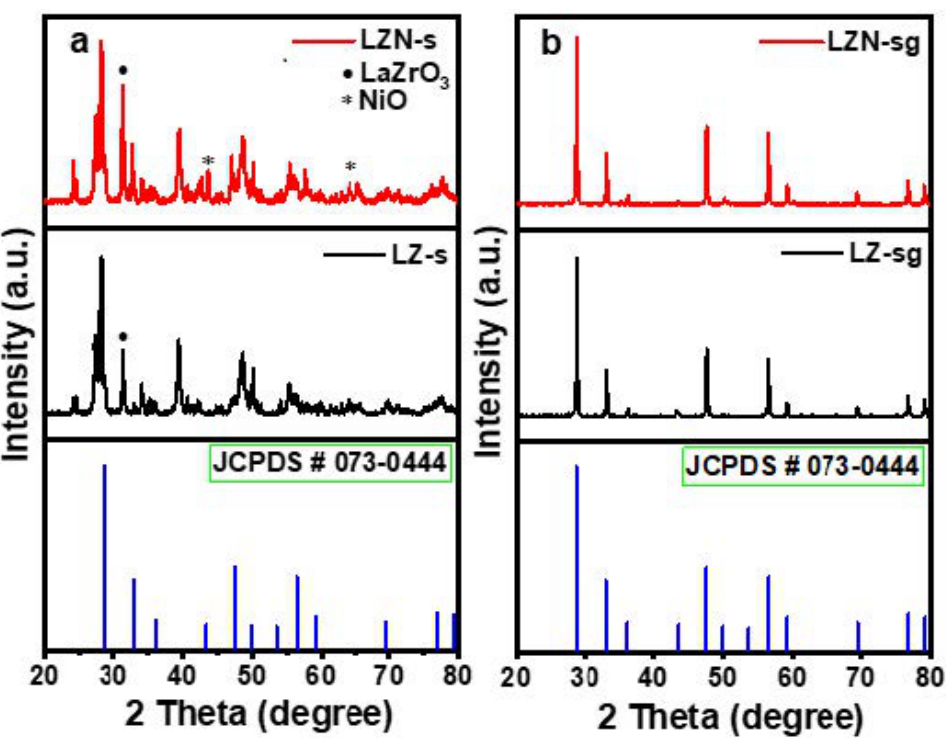
Figure 3. XRD patterns of La 2 Zr 2-x Ni x O 7 (x = 0.0, 0.5) fabricated by the ( a ) solid-state and ( b ) sol-gel routes.